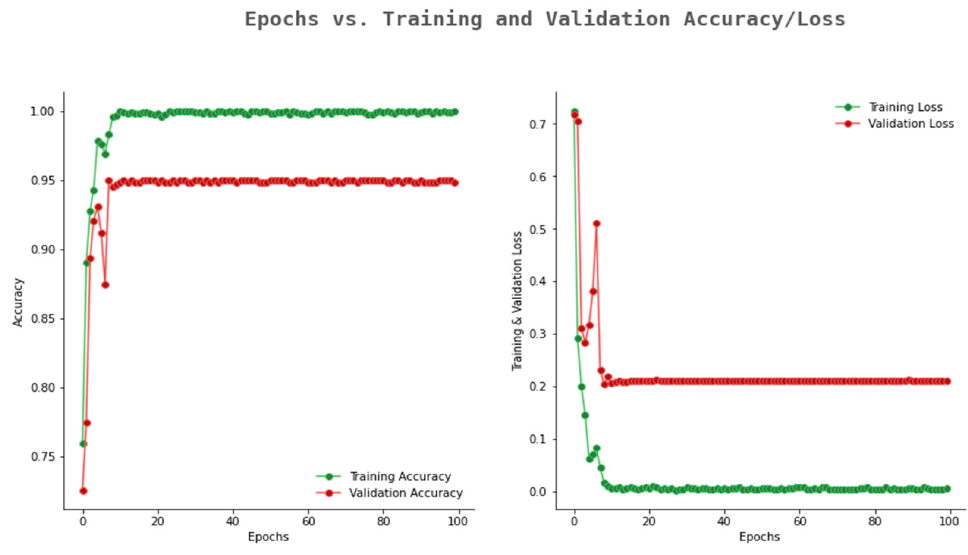
Figure 13. Accuracy and loss graph of Mobile Net.